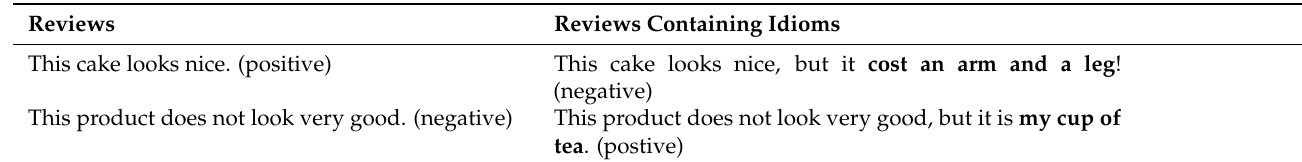
Table 2. Examples of reviews with